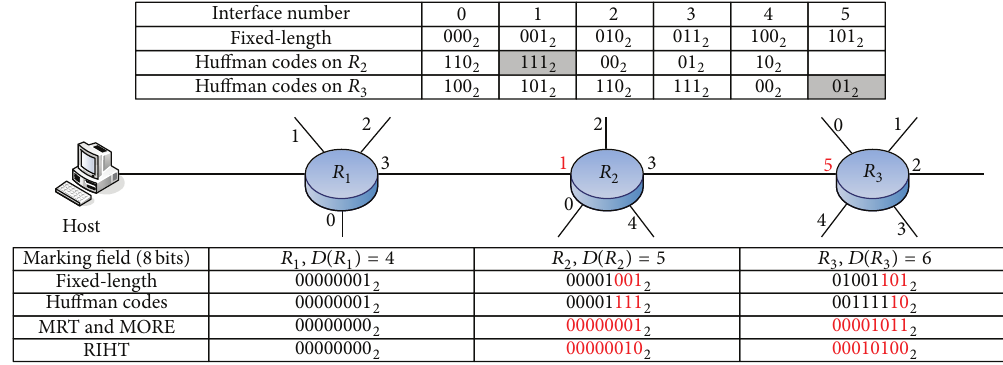
Figure 1: Example of traceback schemes that mark router